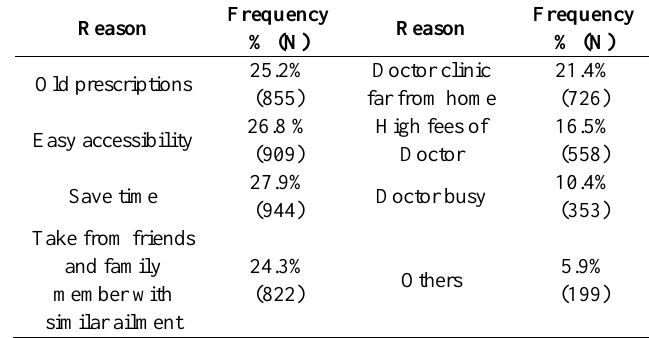
Table 3: reasons for self-medication